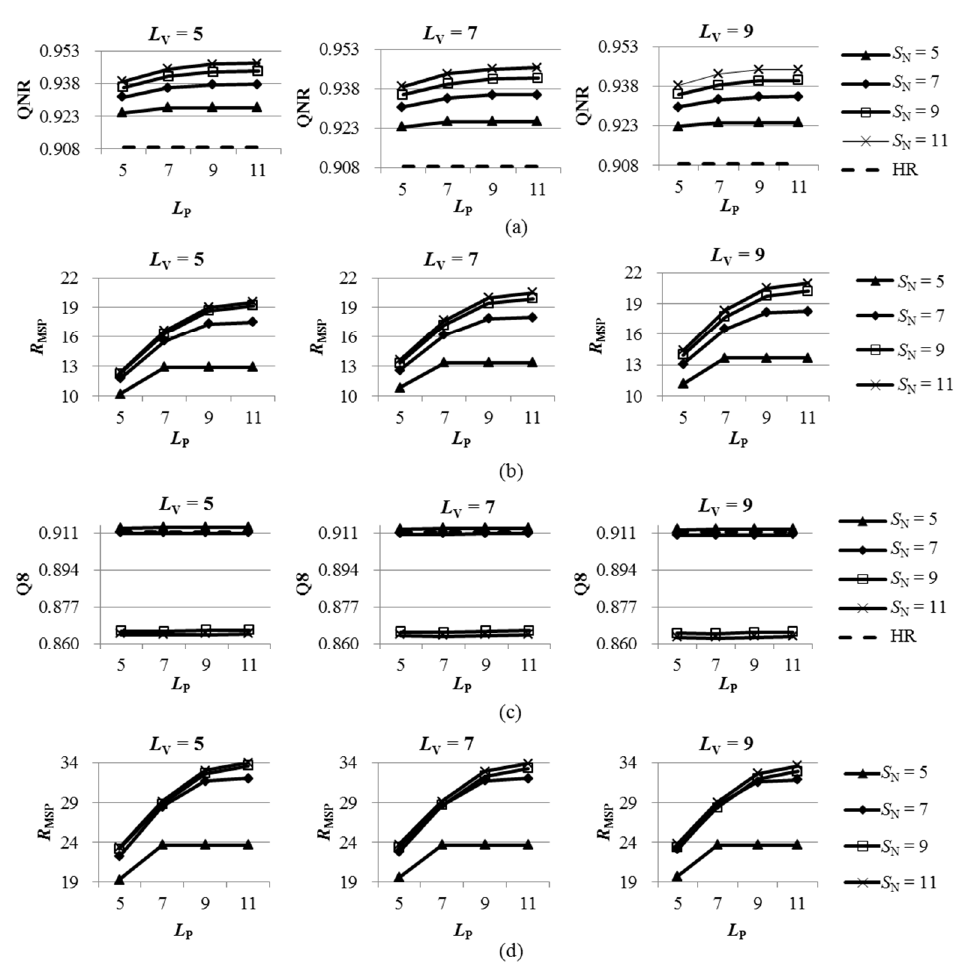
Figure 10. ( a ) QNR and ( b ) ratio of un-mixed MSPs ( R MSP ) for the UHR-fused images produced from the original WV-2 dataset; ( c ) Q8 and ( d ) R MSP for the UHR-fused images produced from the degraded WV-2 dataset.